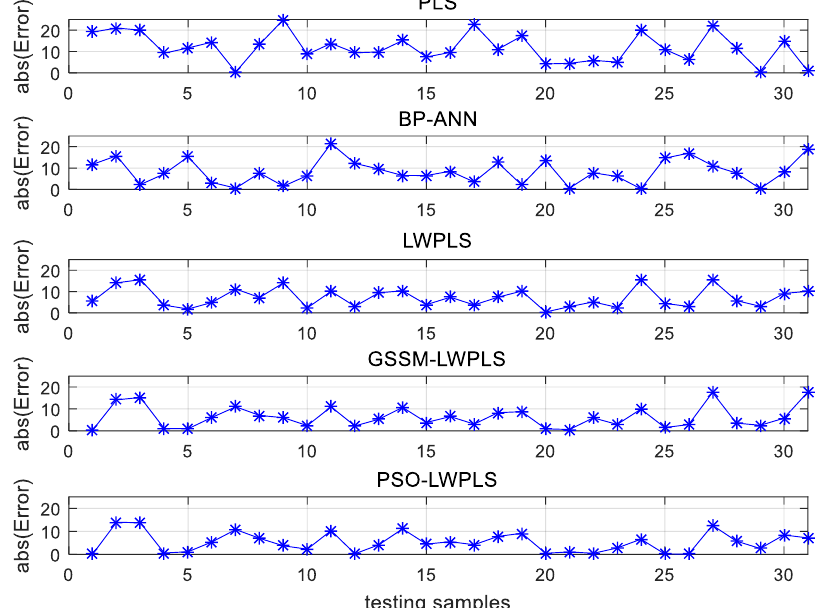
Figure 8. The predicted absolute errors for all the testing samples.